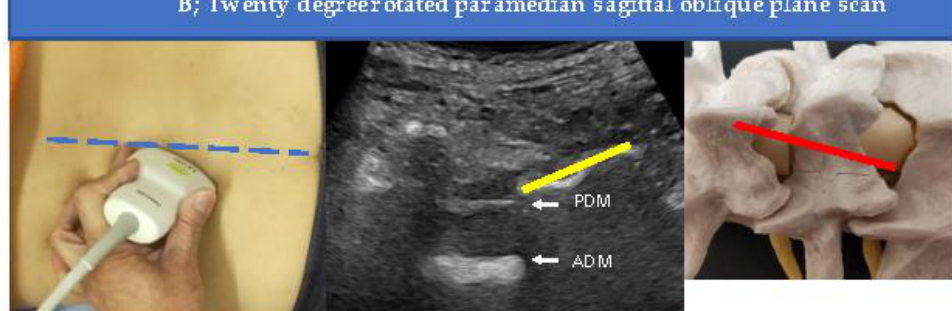
Tomography 2023 , 9 288